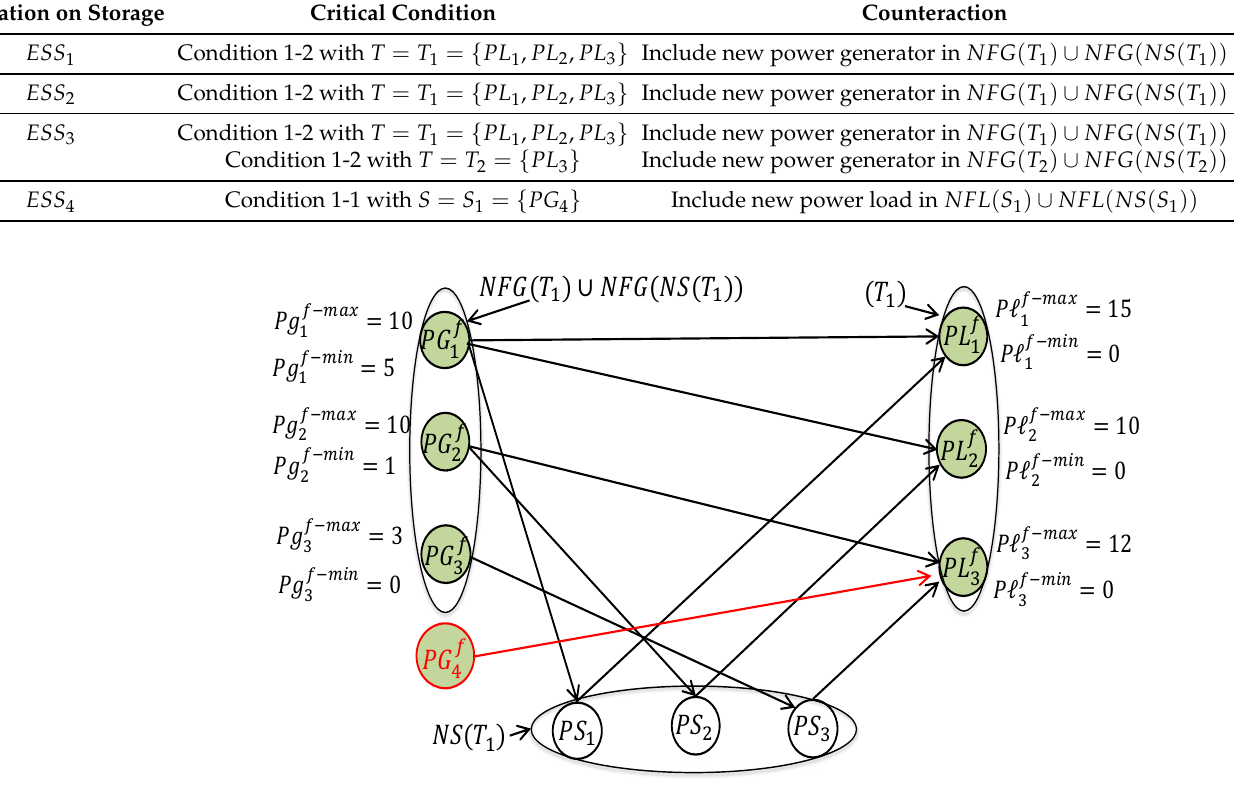
Figure 21. One possible new connection (red line) for making new generator a member of NFG ( T 1 ) ∪ NFG ( NS ( T 1 )) . This connection also contributes to adding a new generator to NFG ( T 2 ) ∪ NFG ( NS ( T 2 )) .